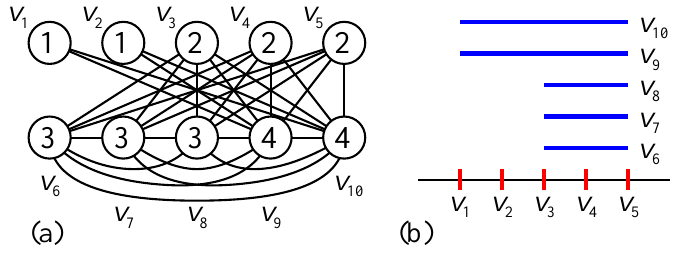
Figure 1. ( a ) Threshold graph and ( b ) its interval